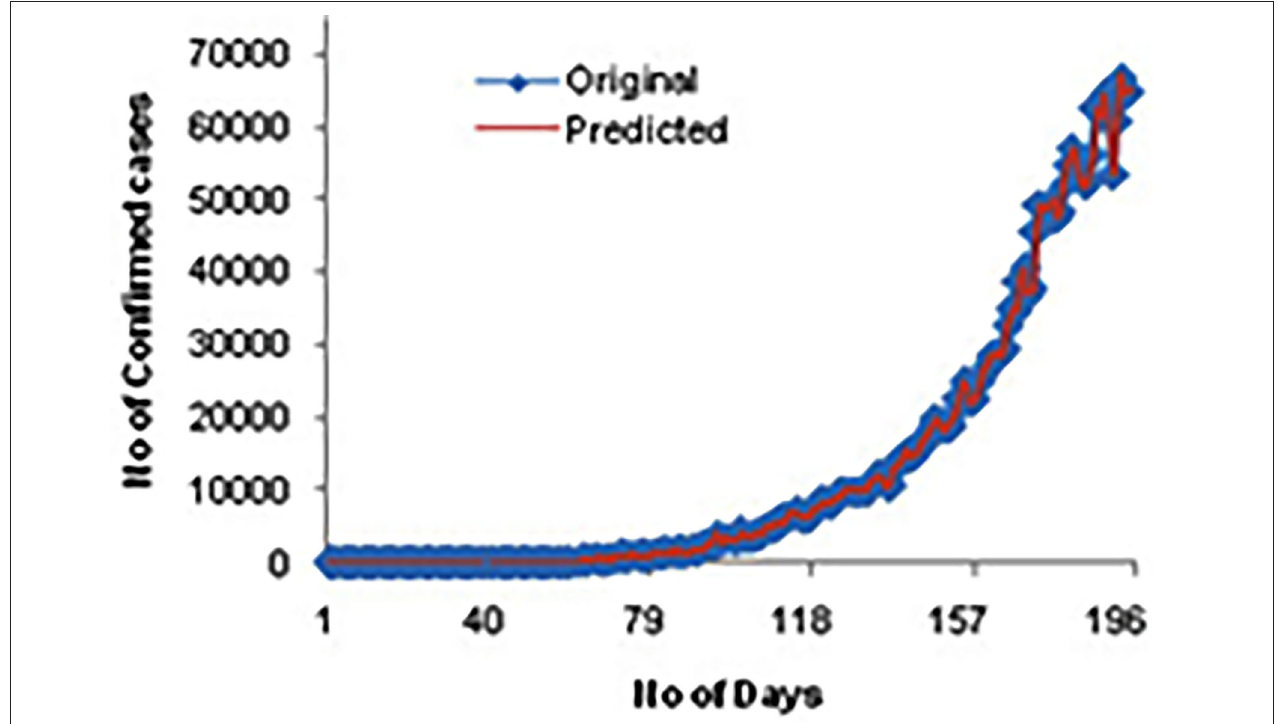
FIGURE 4 | A confirmed case for original and predicted